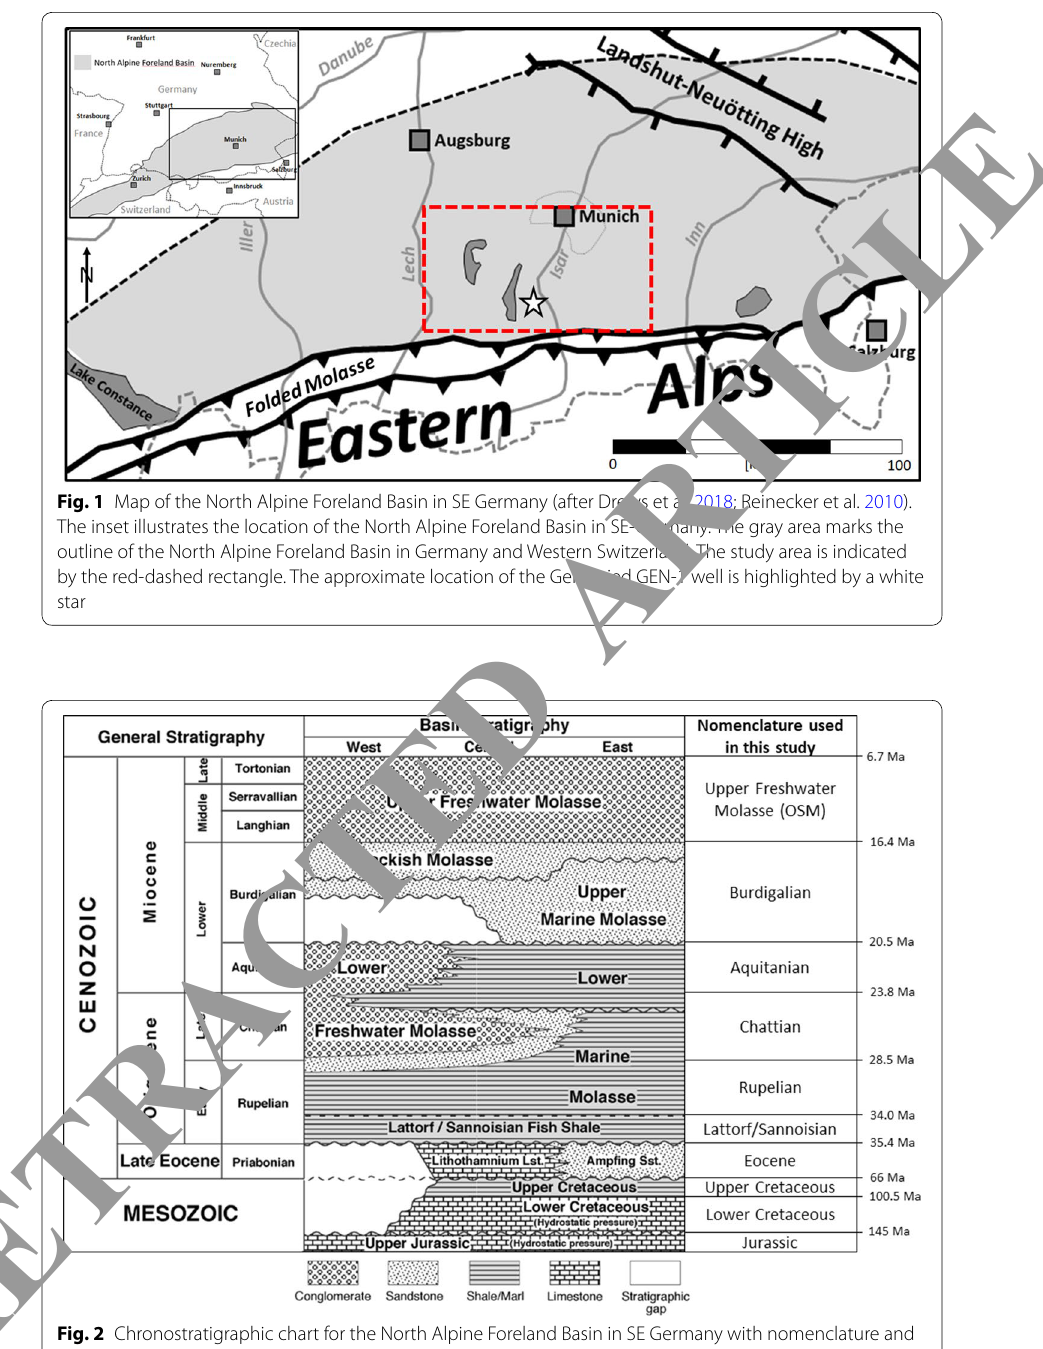
Fig. 2 Chronostratigraphic chart for the North Alpine Foreland Basin in SE Germany with nomenclature and geologic ages (after Drews et al. 2018). Geologic ages for Late Miocene-Rupelian, Sannoisian-Eocene and Mesozoic from Kuhlemann and Kempf (2002), Zweigel (1998) and Cohen et al. (2013),